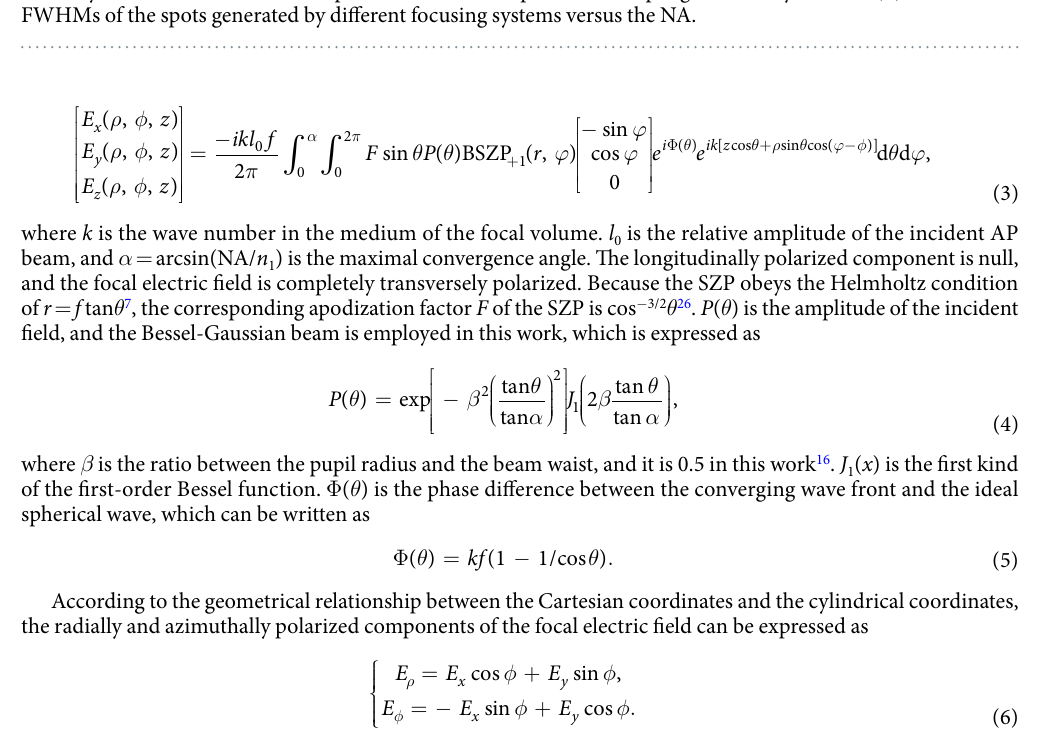
Figure 2. Normalized electric energy density in the focal volume. ( a , b ) Electric energy density profiles along the radial direction on the focal plane. ( c , d ) Electric energy density profiles along the optical axis z . ( a ) and ( c ) are for the total intensity, radial and azimuthal components of the spot generated by the SZP. ( b ) and ( d ) are for the different polarized beams and focusing systems. ( e – g ) Two-dimensional field distributions of the total intensity, radial and azimuthal components on the focal plane for the spot generated by the SZP. ( h ) Lateral FWHMs of the spots generated by different focusing systems versus the